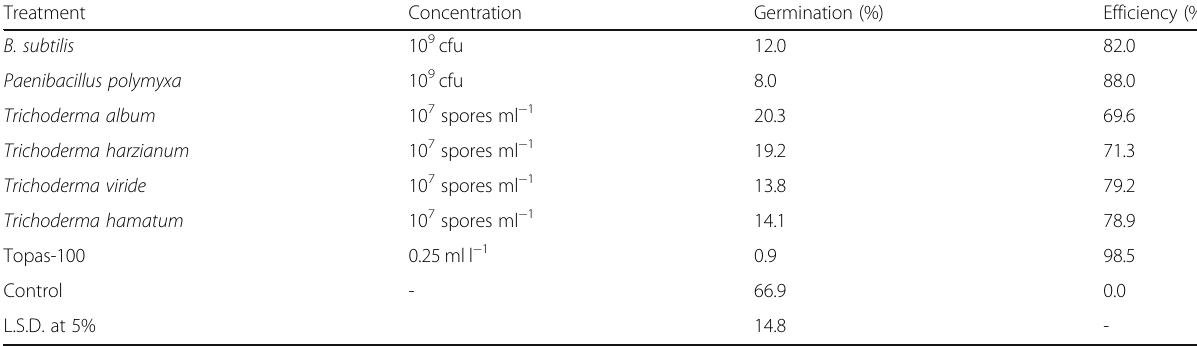
Table 1 Effect of some bio-agent on spores ’ germination of Podosphaera xanthii , in vitro Treatment